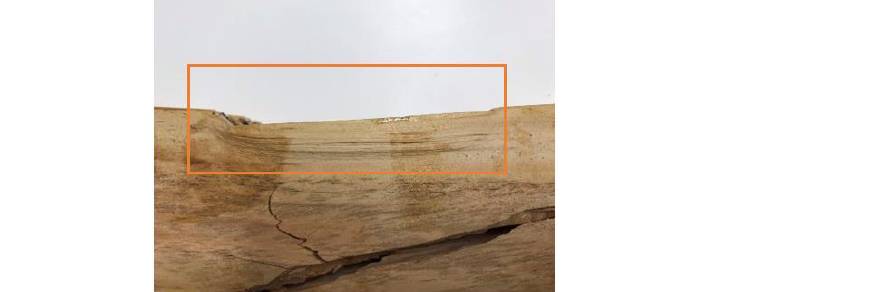
Figure 5. A 40 × 80 sample piece from benchmark case 1 ( left ) compared to the most promising reinforced 40 × 80 sample Case 4 ( right ) after loading. Figure 6. A 40 × 40 sample piece from benchmark case 1 ( left ) compared to the most promising reinforced 40 × 40 sample Case 5 ( right ) after loading.